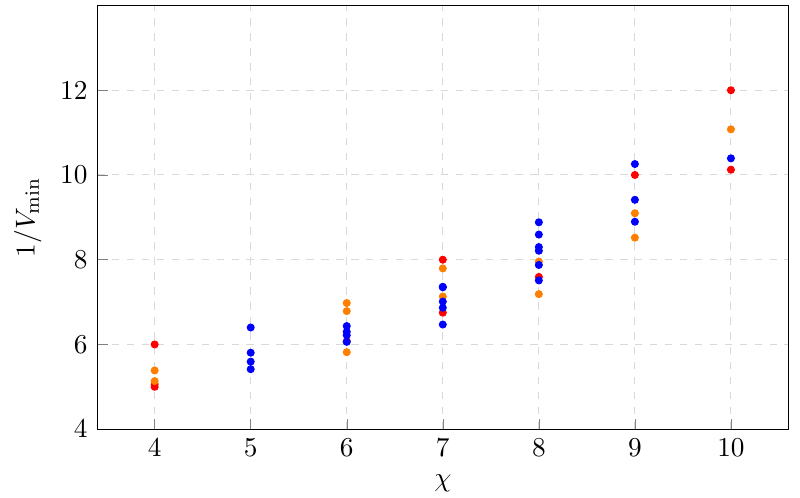
Figure 6. The red points correspond to regular Sasaki-Einstein manifolds while the quasi-regular ones are in orange. We omit the (cid:12)rst-grade points in the